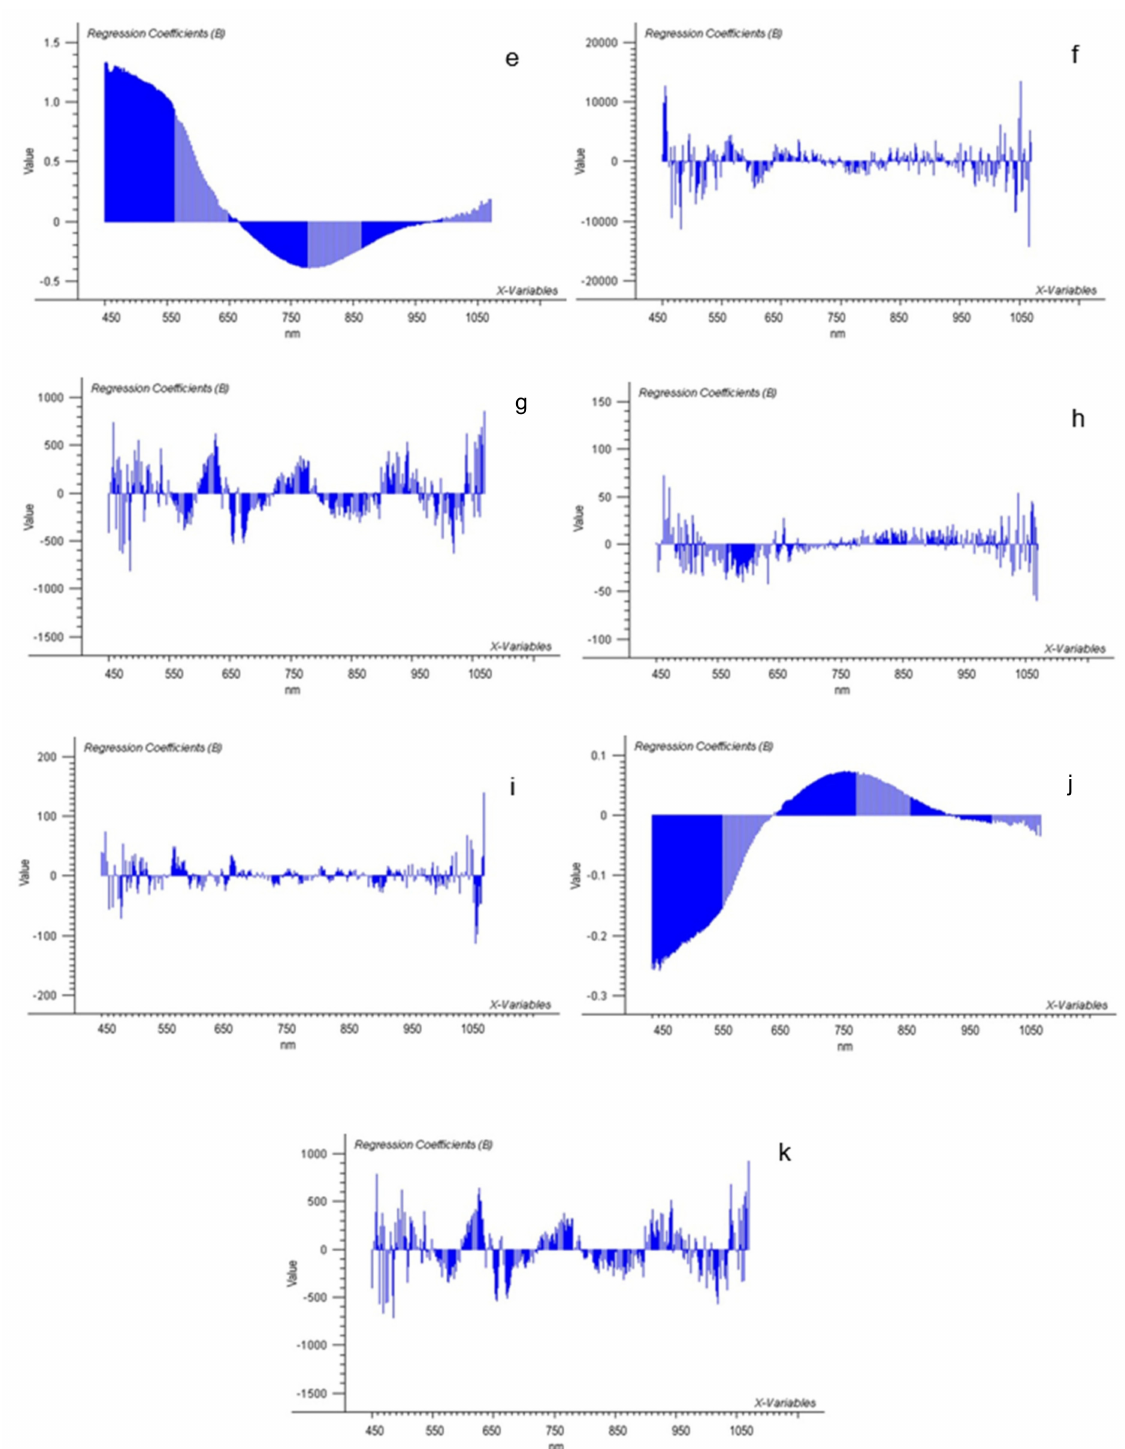
Figure A3. Regression coefficients as a result of PLSR model for 11 chemical soil properties from control (CON), medium severity (MS), and high severity (HS) treatment: ( a ) OC; ( b ) pH; ( c ) EC; ( d ) P 2 O 5 ; ( e ) K 2 O; ( f ) CaCO 3 ; ( g ) ex Ca; ( h ) ex Mg; ( i ) ex K; ( j ) ex Na; ( k ) CEC; ( n = 120). Significant wavelengths are marked as dark blue at a p <